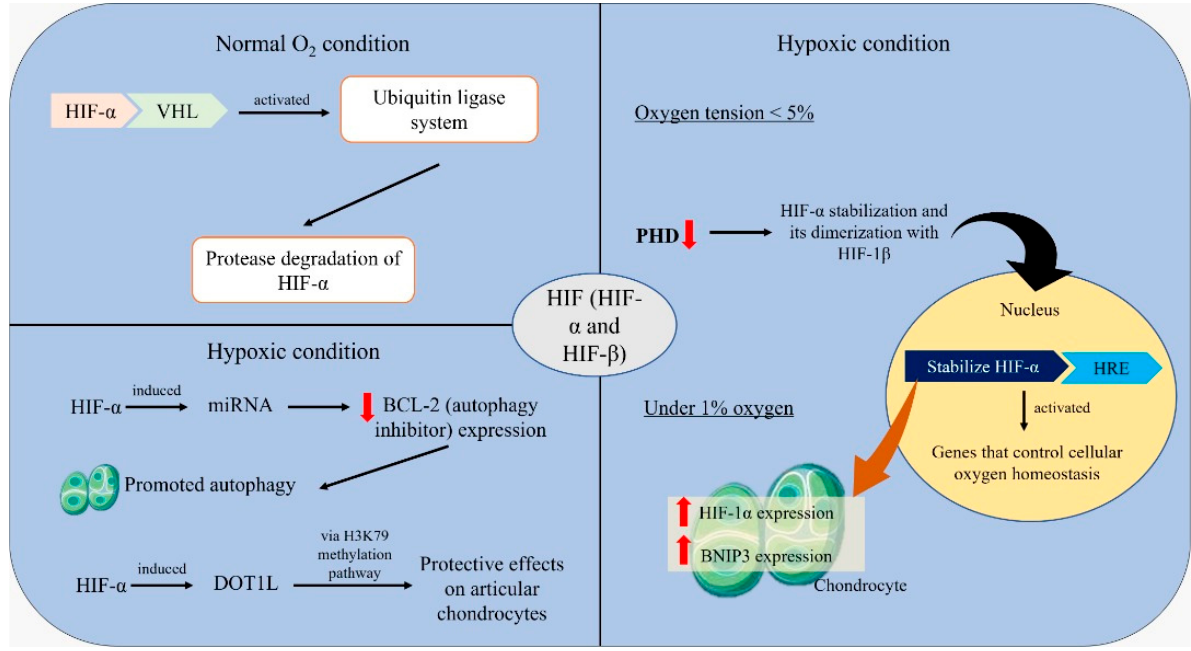
Figure 4. Illustration of mechanisms of hypoxic regulation.